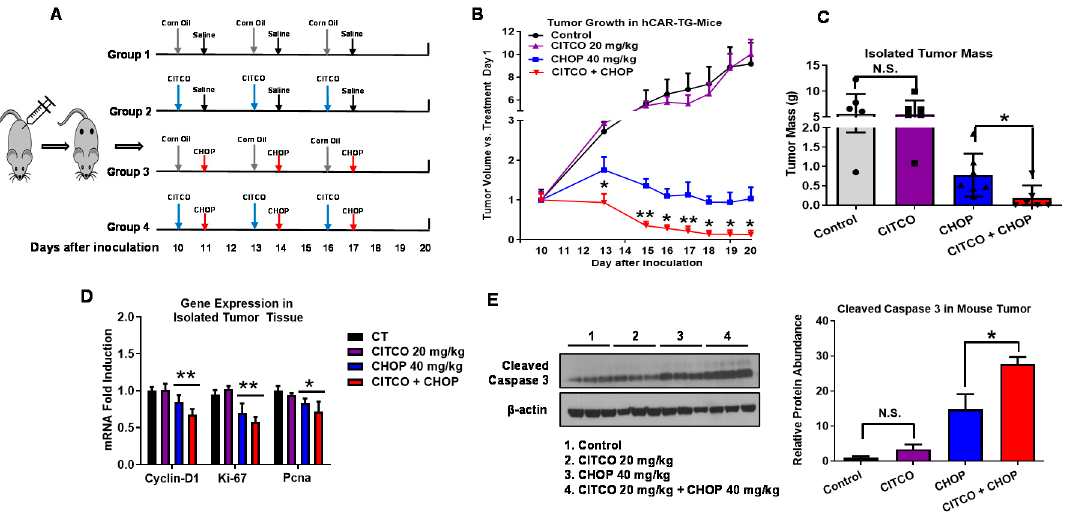
Figure 3. CITCO improves the anticancer activity of CHOP against EL-4 xenograft in hCAR-TG-mice. hCAR-TG-mice inoculated with EL-4 cells for xenograft formation as detailed in Section 2 were divided into 4 groups and treated with vehicle control (corn oil), CITCO (20 mg/kg, IP), CHOP (40 mg/kg, IP) or CITCO + CHOP as depicted in ( A ). Tumor volumes ( B ) from different groups were measured for 20 days post cell injection as indicated. At the end of experiment, tumor weights ( C ) were also measured before stored at − 80 °C. mRNA expression of Cyclin D1, ki67, and Pcna was detected using RT-PCR ( D ). Cleaved caspase 3 was measured using Western blotting ( E ). Data represent mean ± SD, n = 3–7. *, p < 0.05; **, p < 0.01, NS, not significant